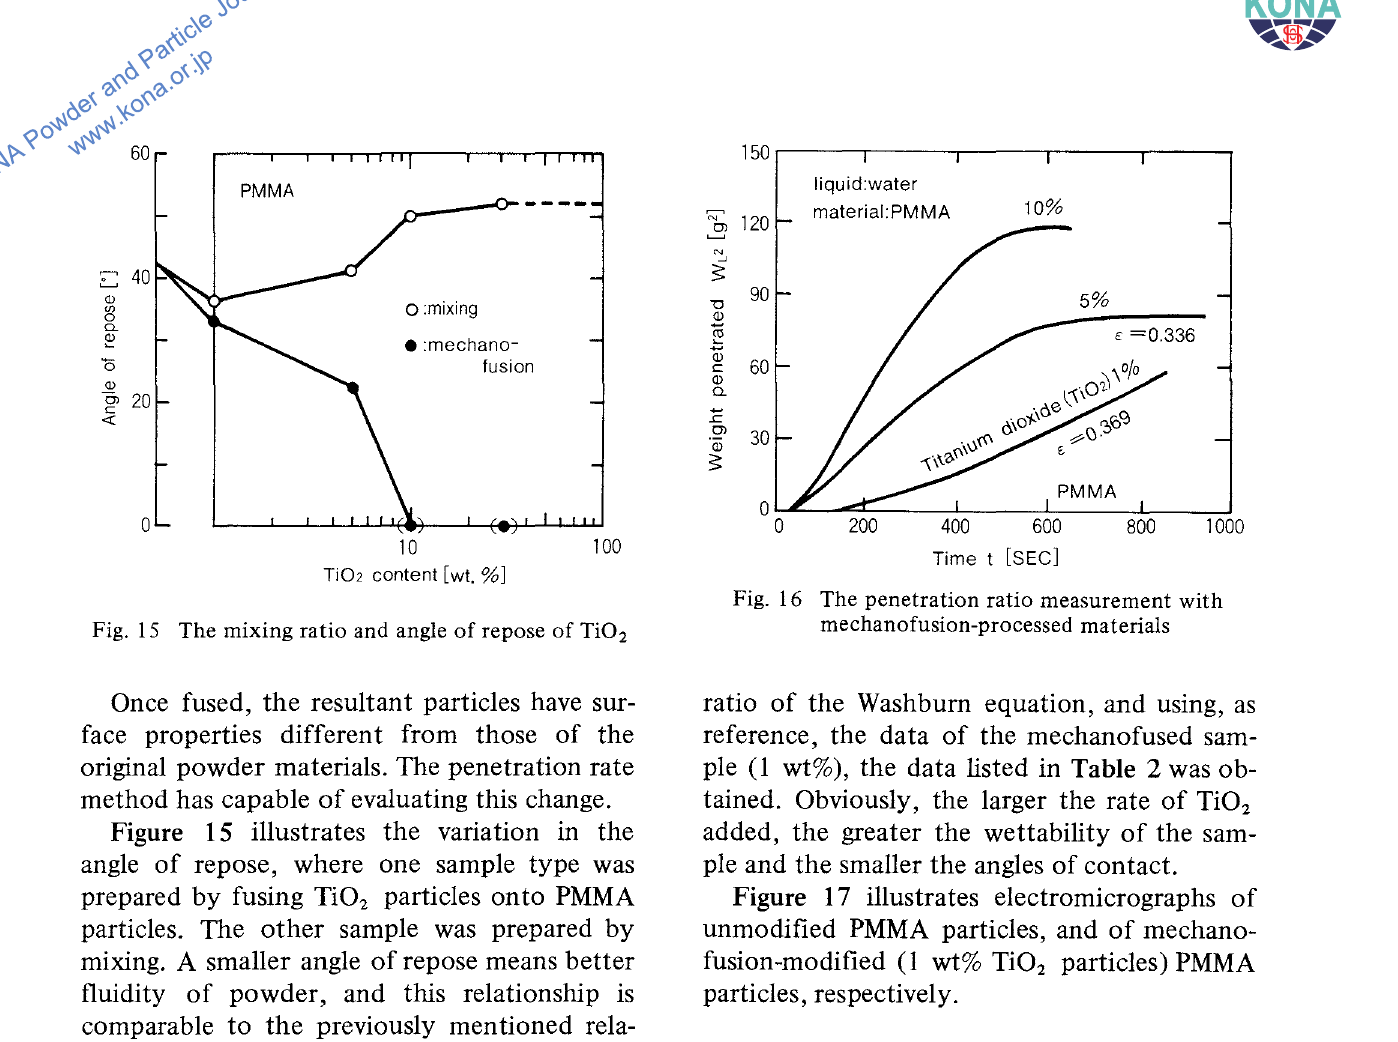
Fig. 1 7 Mechanofusion of PMMA particles